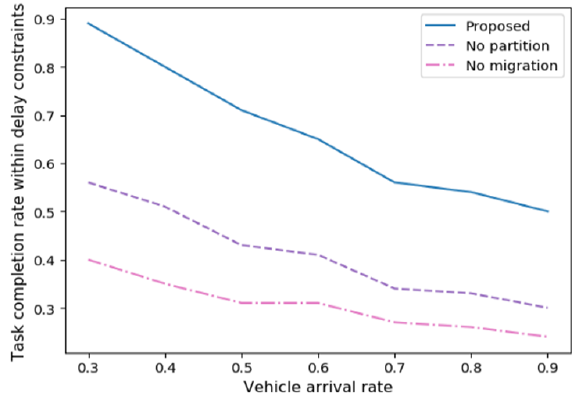
Figure 5. Task completion rates of the three methods.